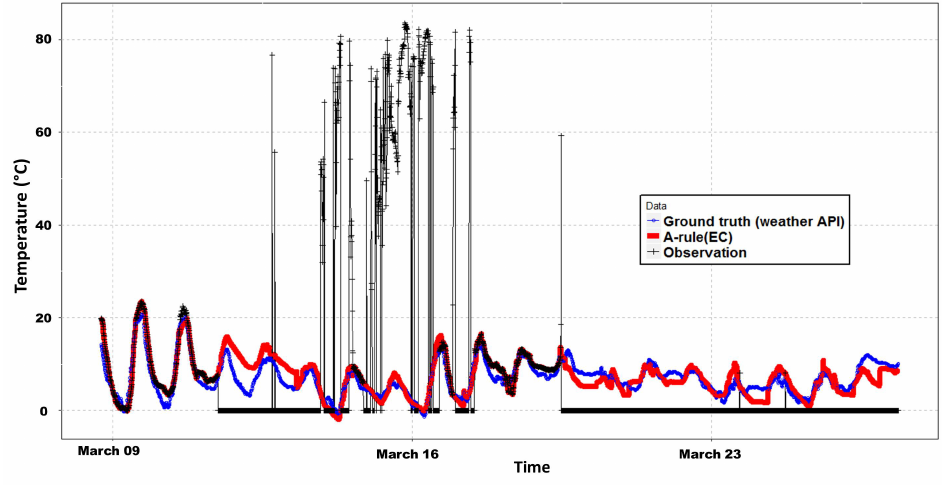
Figure 8. Detection and correction of real faulty data from Figure 1b.